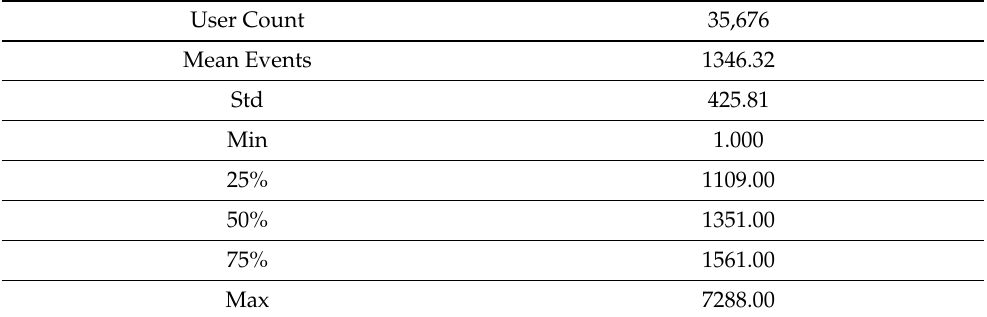
Table 1. Dataset analysis on number of events per user.